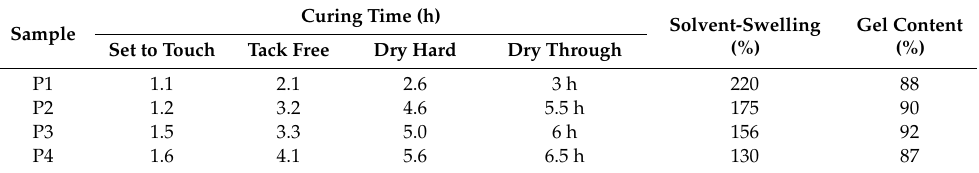
Table 3. films made with different crosslinkers.